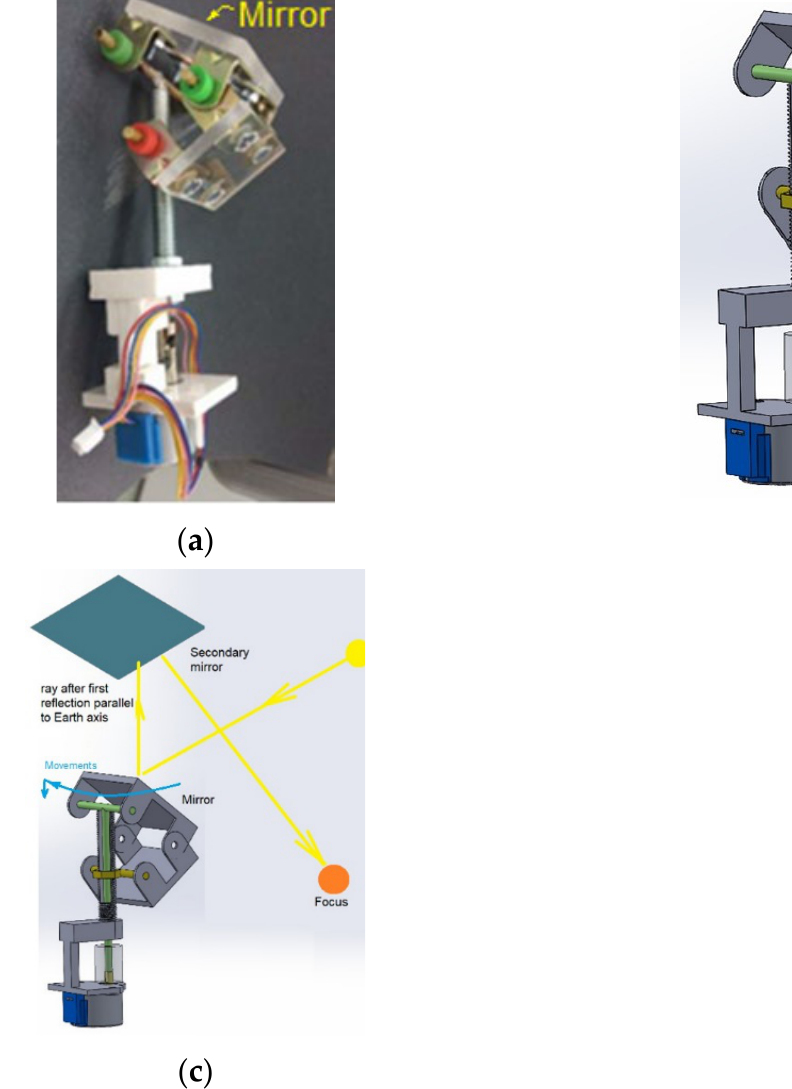
Figure 9. Location plan of the distribution of the heliostatic illuminators in the scale model of the classroom of the Leonardo da Vinci building of the Rabanales University Campus of the University of Córdoba (Spain).